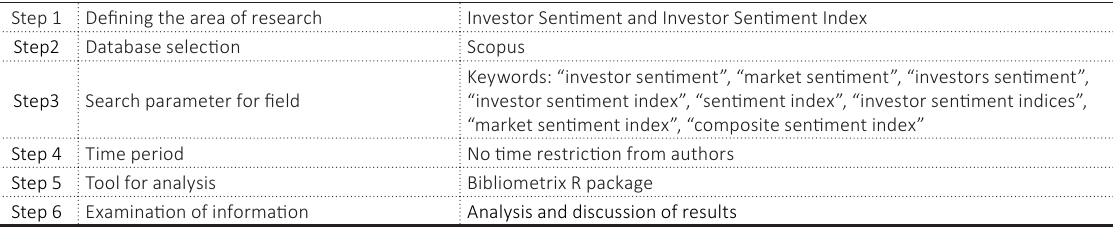
Figure 2. The effective key terms employed in